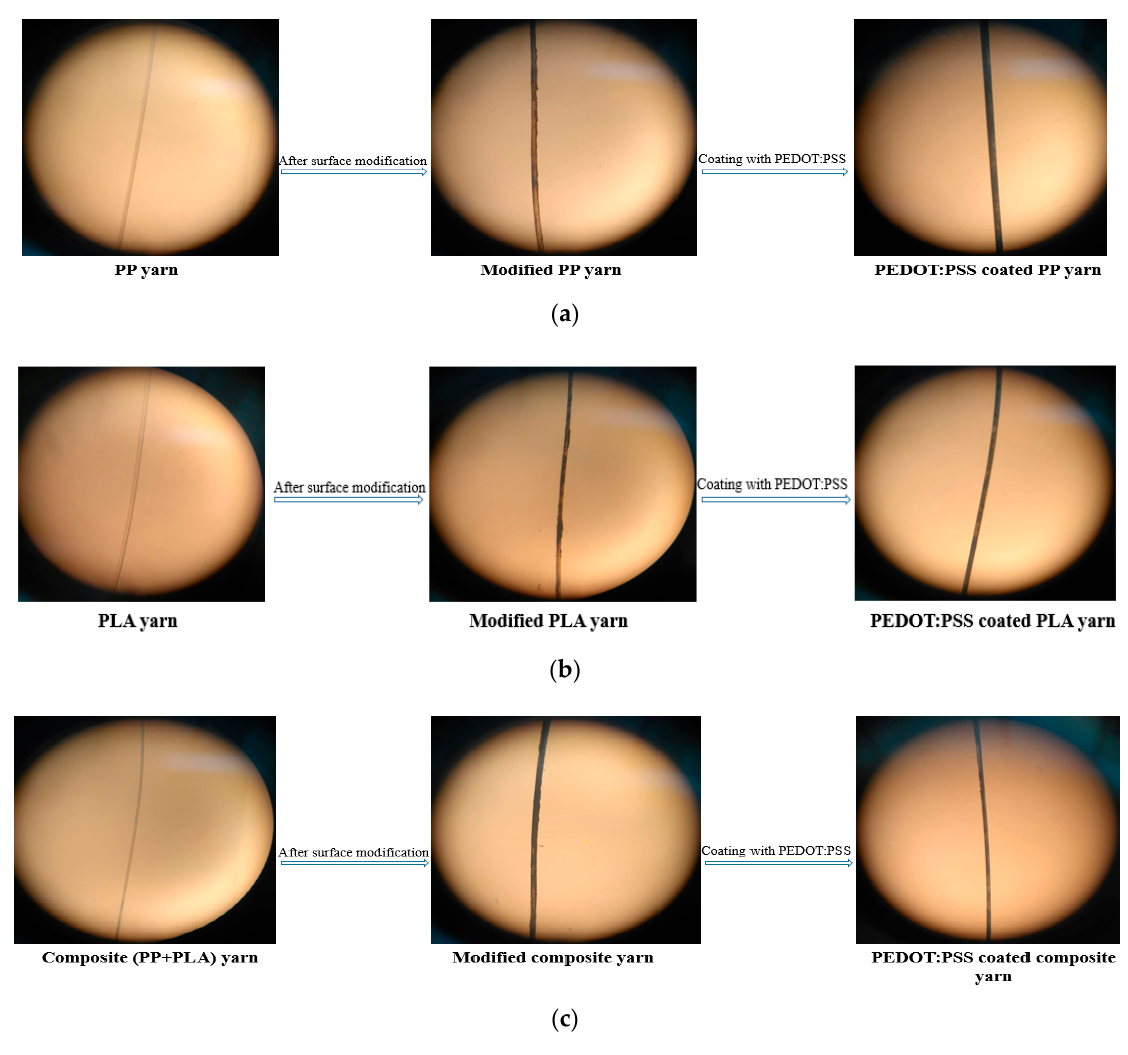
Figure 8. Optical microscopic images of conductive ( a ) PP, ( b ) PLA and ( c ) blend PP/PLA yarn.